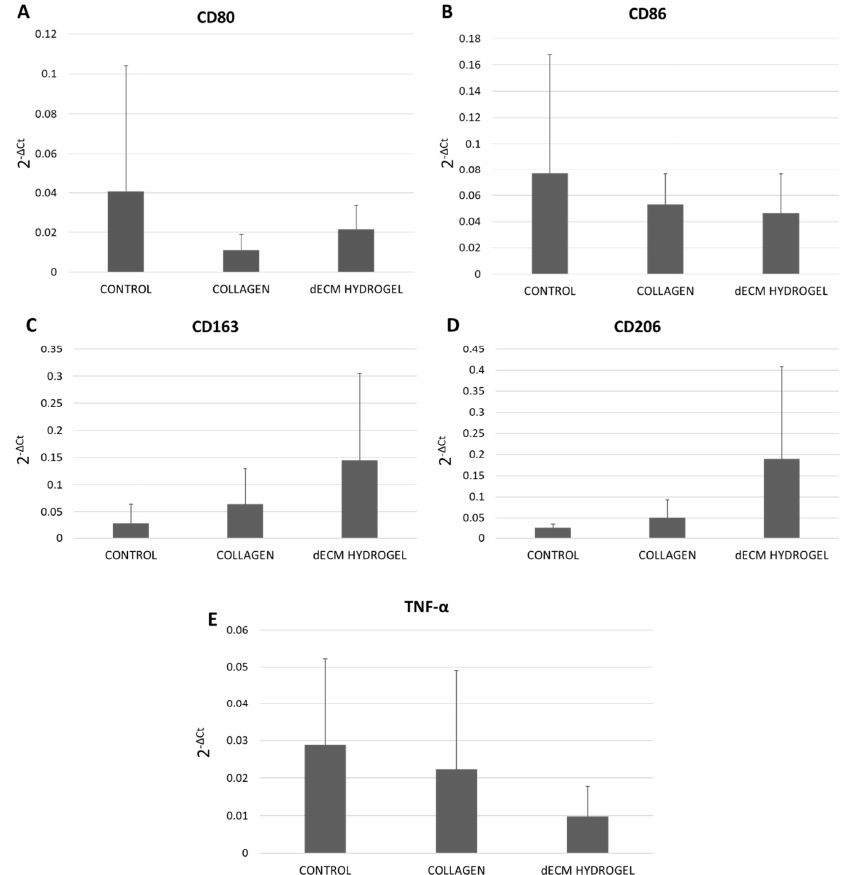
Figure 2. Immunomodulatory potential of dECM hydrogel. ( A ) Gene expression of M1 phenotype marker CD80 in monocyte-derived macrophages on 4 mg/mL dECM hydrogel coatings. ( B ) Gene expression of M1 phenotype marker CD86 in monocyte-derived macrophages on 4 mg/mL dECM hydrogel coatings. ( C ) Gene expression of M2 phenotype marker CD163 in monocyte-derived macrophages on 4 mg/mL dECM hydrogel coatings. ( D ) Gene expression of M2 phenotype marker CD206 in monocyte-derived macrophages on 4 mg/mL dECM hydrogel coatings. ( E ) Gene expression of TNF- α in monocyte-derived macrophages cultured on 4 mg/mL dECM hydrogel coatings. Results are expressed as 2 −Δ Ct . Data are means ± S.D. of 6 independent experiments from distinct donors.